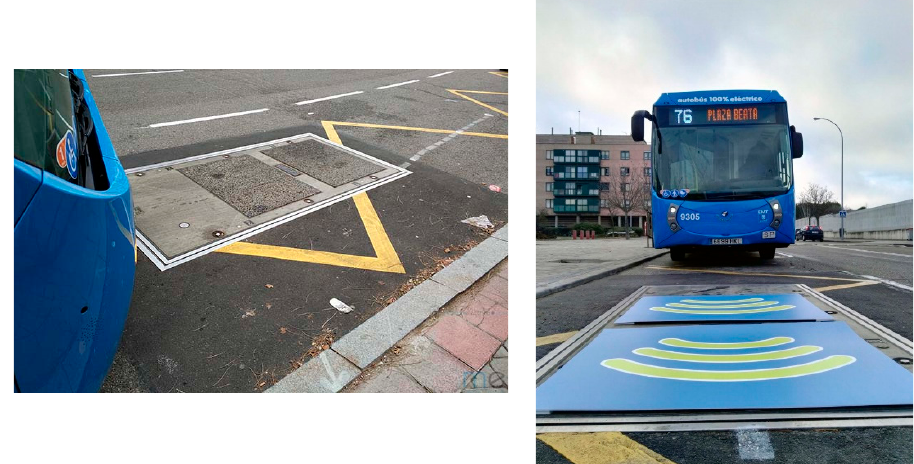
Figure 3. Pictures of induction charging in the street: line 76 (Madrid).